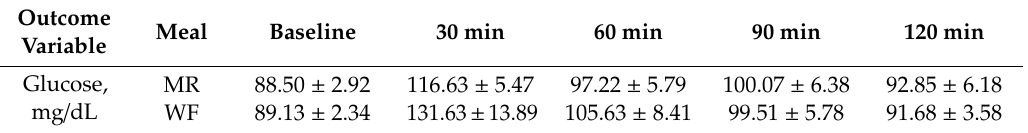
Figure 4. ( A ) Postprandial change in glucose across 120 min for each meal. ( B ) Effect of test meals on the 120 min postprandial period area under the curve for glucose of meal following the two test meals. MR: meal replacement meal; WF: whole food meal. Data displayed as mean ± standard error. Table 5. Effects of meal type on mean blood glucose at baseline and 30, 60, 90, and 120 min in the postprandial period a .